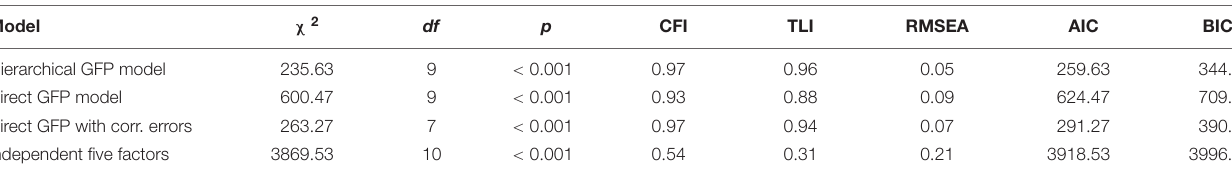
FIGURE 1 | The hierarchical GFP model and its association with resilience. TABLE 2 | Fit indices for different